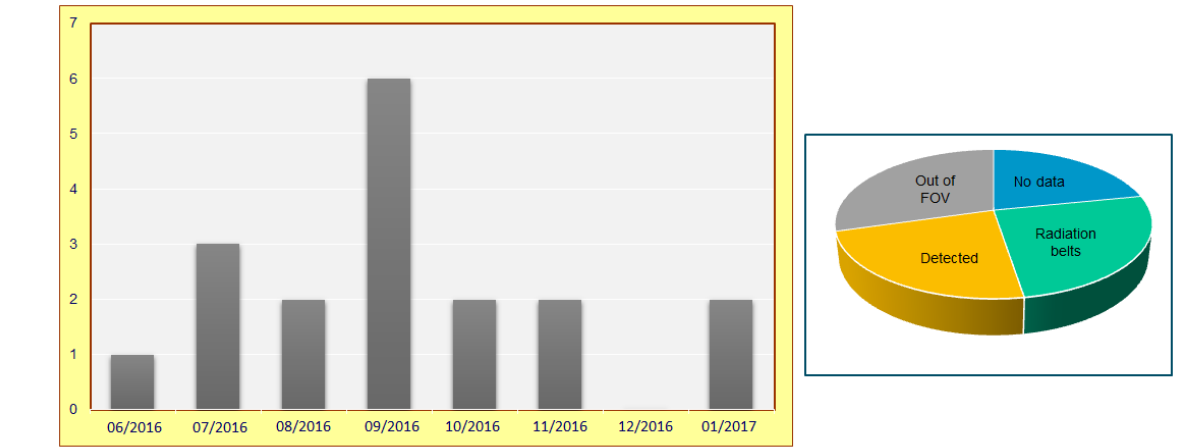
Figure 3. Statistics of GRBs observed by BDRG/Lomonosov. Table 3. List of GRBs detected using